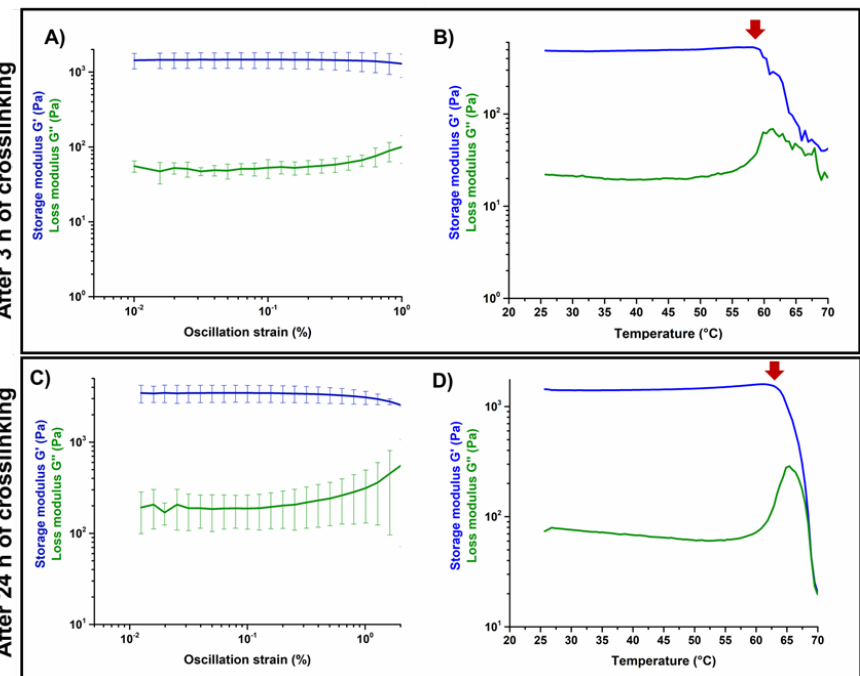
Figure 6. Amplitude sweep test ( A , C ) and temperature ramps ( B , D ) performed on GEN- Coll/MBG_Sr4% after 3 h and 24 h.